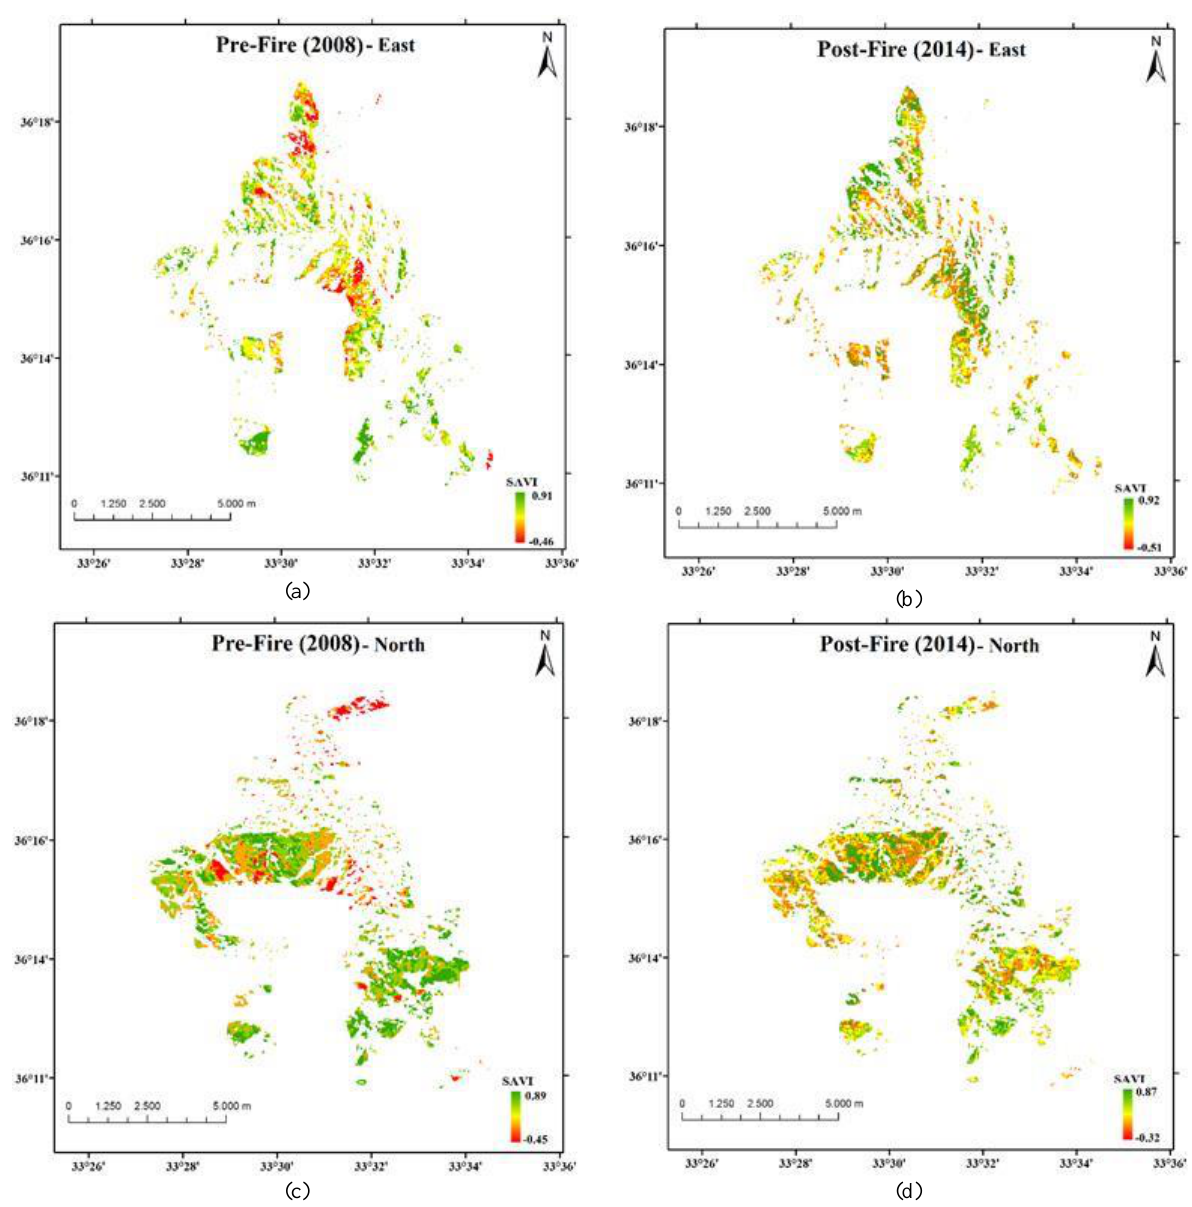
Figure 4. SAVI change maps for slope aspects (a) 2008 East, (b) 2014 East, (c) 2008 North, (d) 2014